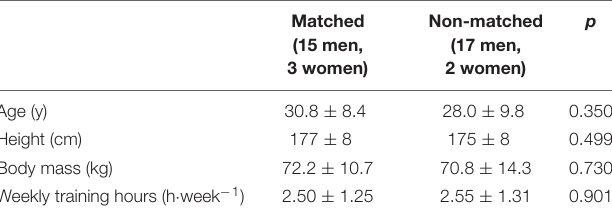
TABLE 1 | Mean ± SD of baseline participant characteristics for matched and non-matched groups.